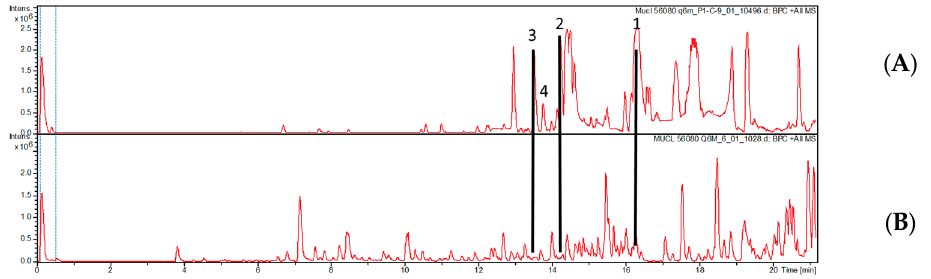
Figure 3. HPLC chromatogram (210 nm) of the crude extracts of E. brachypora MUCL 56080 grown in Q61/2 media ( A ) and Q6 + antibiotics ( B ). Compounds 1 – 4 were only produced in the absence of the antibacterial antibiotic.